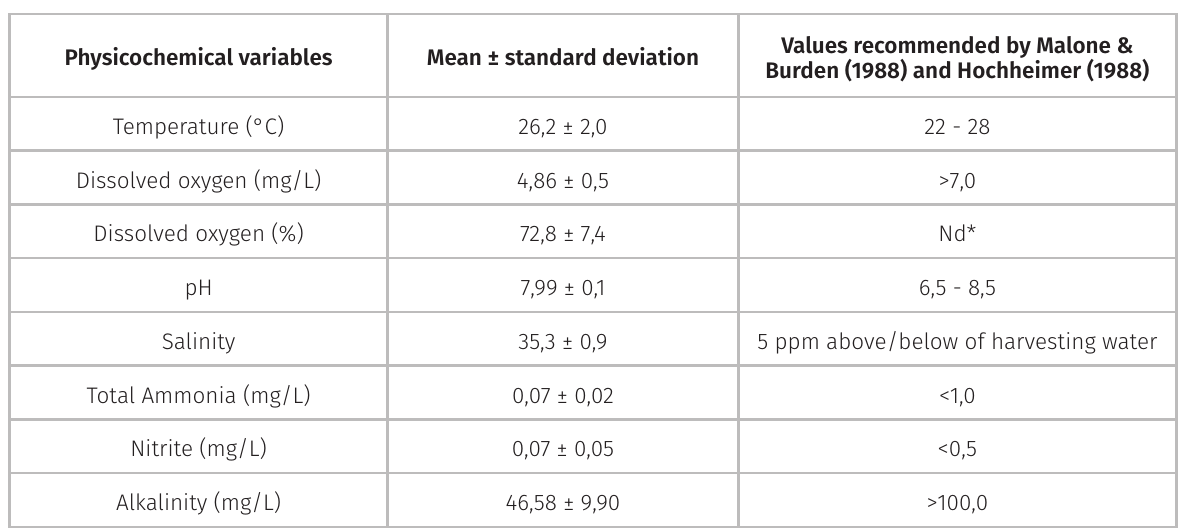
Table I. Mean ± standard deviation of water quality variables of the experimental system and recommendations of optimal conditions for farming of swimming crabs by Malone & Burden (1988) and Hochheimer (1988). Physicochemical variables